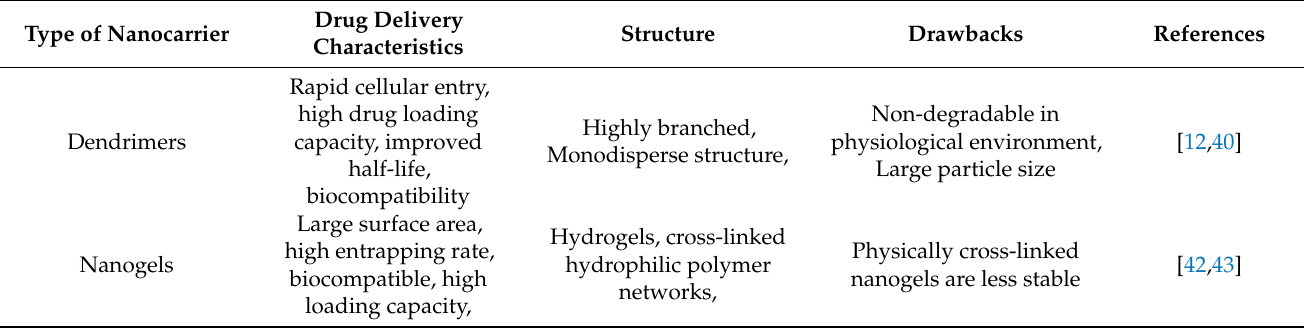
Table 2. Summary of